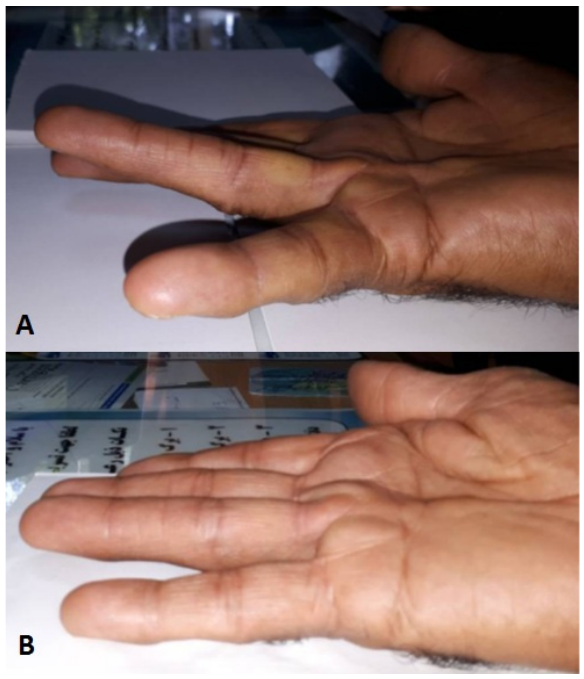
Figure 1. Flexion contracture in a patient with Dupuytren’s contracture before treatment with radial extracorporeal shock wave (A); Flexion contracture in a patient with Dupuytren’s contracture one week after treatment with radial extracorporeal shock wave